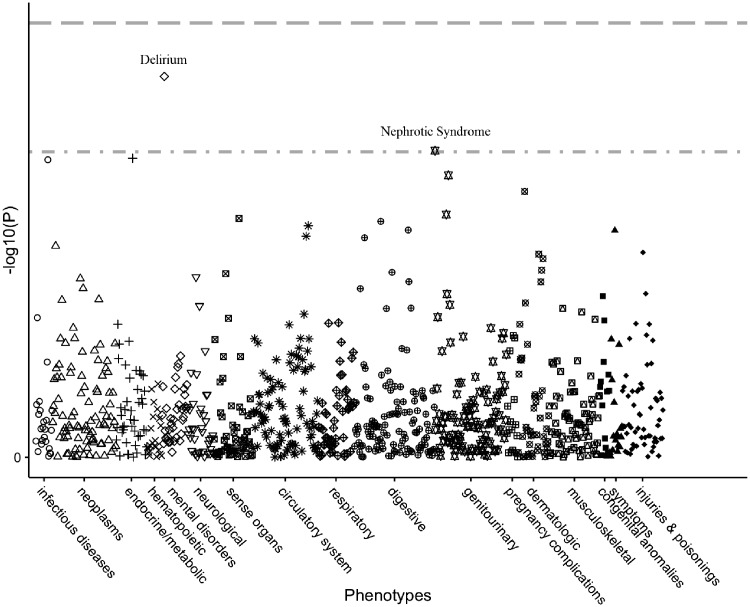
Manhattan plot for results of PheWAS analysis. Phenotypes aggregated on International Classification of Disease codes were plotted with the –log10 P-value of each association. The first line indicates a Bonferroni-corrected P-level of 5.44 × 10–5 and the second line indicates a P-level of 0.001. No phenotype survived Bonferroni correction. There were only two phenotypes with a P-value <0.001, which were delirium (P = 1.83 × 10–4) and nephrotic syndrome (P = 9.75 × 10–4).